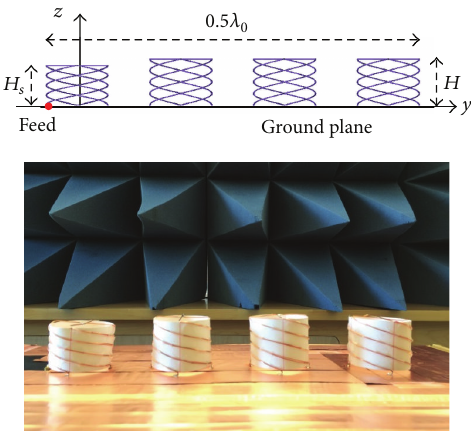
Figure 9: 1D compact, closely spaced backfire antenna